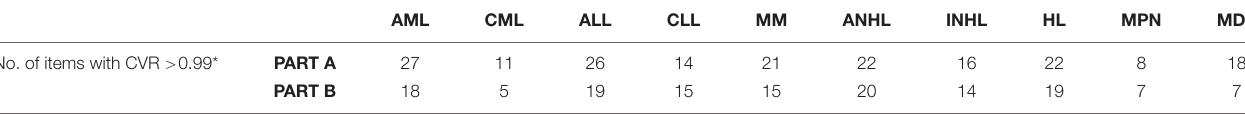
TABLE 7 | Content validity ratio across HM. AML CML ALL CLL MM ANHL INHL HL MPN